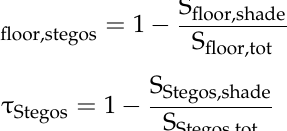
Figure 14. Comparisons between simulations on Rhinoceros Grasshopper and photographs of Stegos in solar cap configuration. ( a ) Comparison of the vertical shadow for an angle of 90 ◦ . Date: 27 October 12:00. ( b ) Comparison of the horizontal shadow on the floor of the test box for an angle of 90 ◦ . Date: 19 November